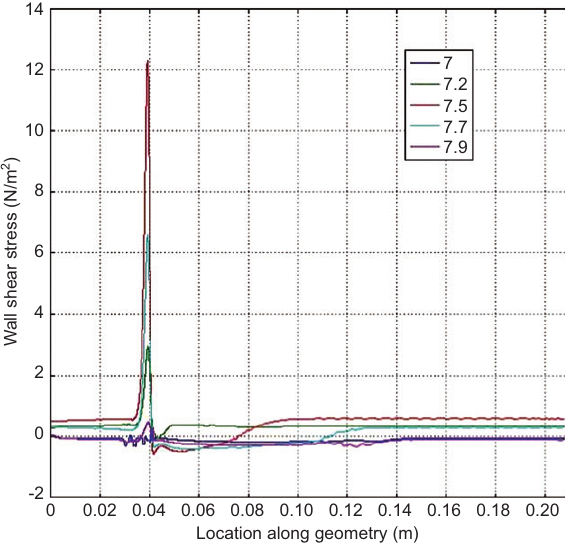
Figure 3 WSS for 50 % stenosis pulsatile Generalized Power Law model at various time intervals, with 0.11196 m/s max inflow rate.